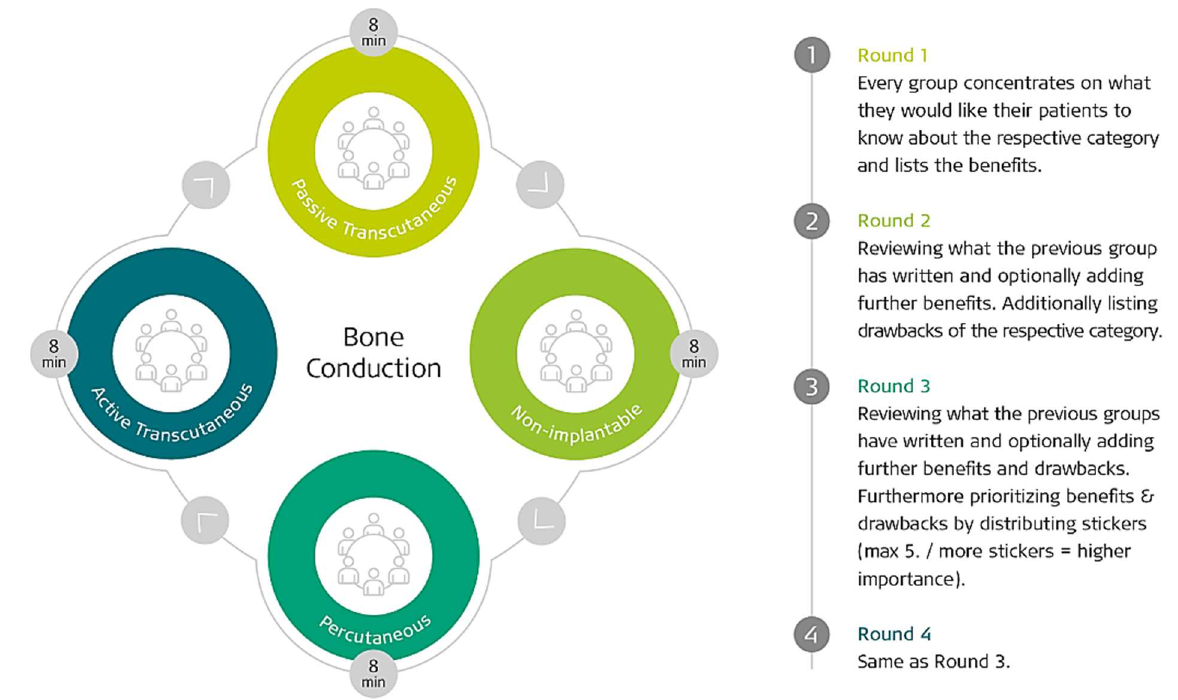
Figure 1. The four tables and how participants rotated. In this example they were discussing bone conduction solutions.